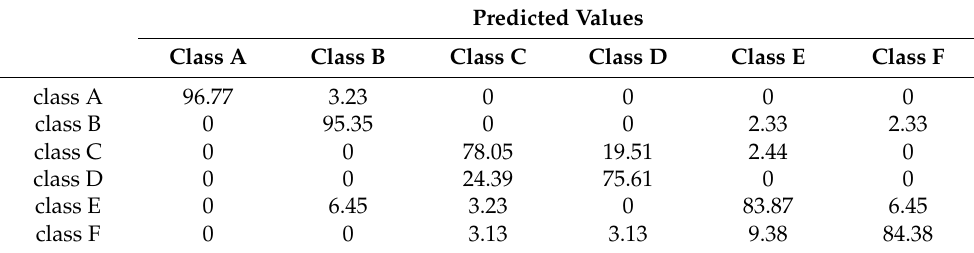
Table 1. Results in terms of accuracy for each eye movement and visual state for random forests.